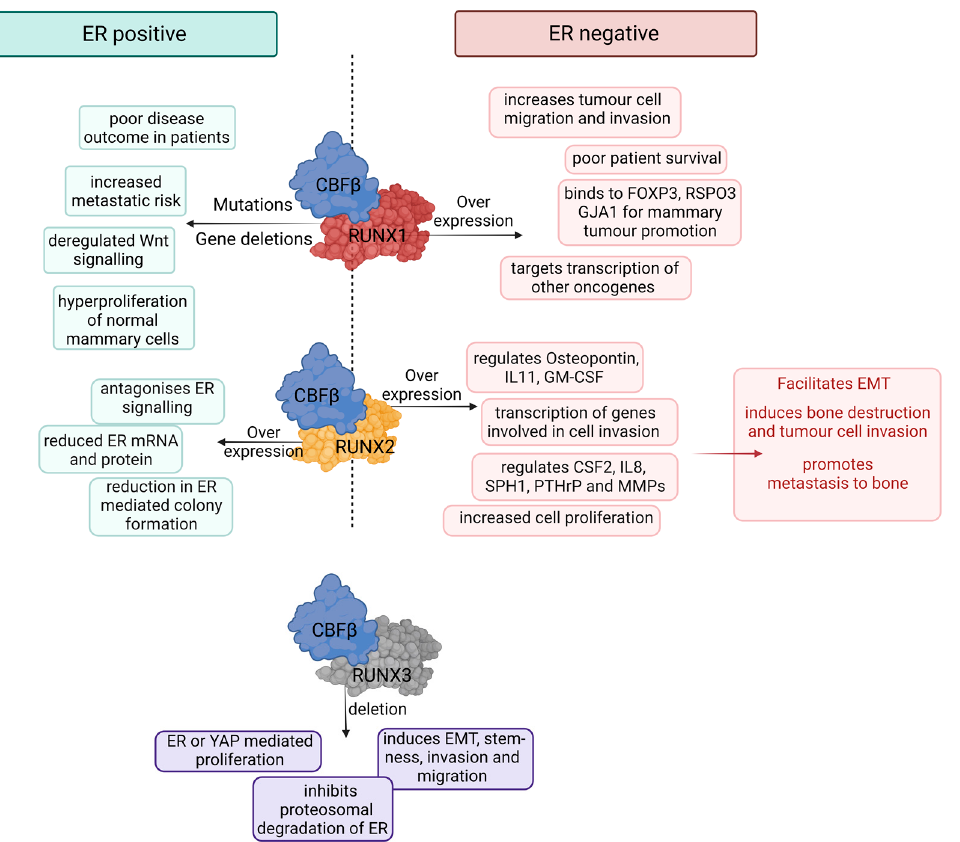
Figure 3. Schematic summarizing the knowledge around each of the RUNX proteins in ER positive and ER negative breast cancer. The RUNX1/CBF β complex acts in a tumor suppressor manner in ER positive disease and is pro ‐ tumorigenic in ER negative disease. The RUNX2/CBF β complex is a critical regulator of metastasis in ER negative disease and has been shown to antagonize ER/E2 signaling inducing reduced expression of ER mRNA and protein. RUNX3 hypermethylation, gene deletions and polymorphisms have been reported in breast cancer samples while gene deletion in vitro is associated with ER and YAP1 mediated proliferation, induction of EMT, invasion and migration of breast cancer cells.